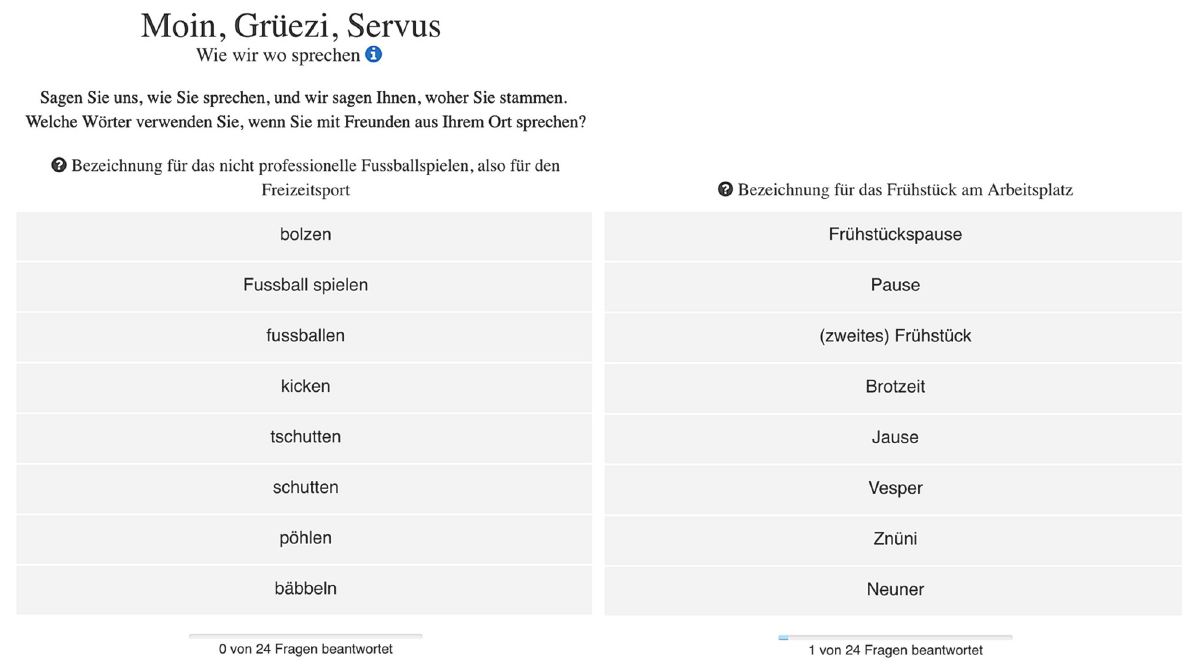
Fig 1. UI showing regional variants for ‘non-professional soccer playing’ (left) and ‘(second) breakfast that people have at their workplace’